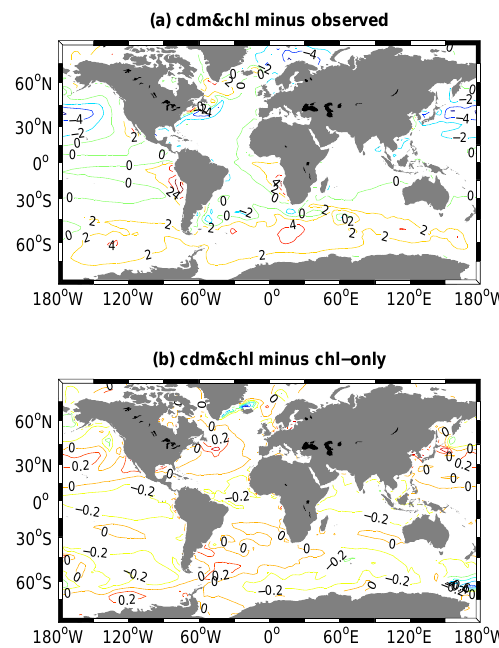
Figure 8. Difference in annual average SST in ◦ C for (a) chl&CDM minus observed using the NOAA_OI_SST_V2 data set (Reynolds, 2002) and (b) chl&CDM minus